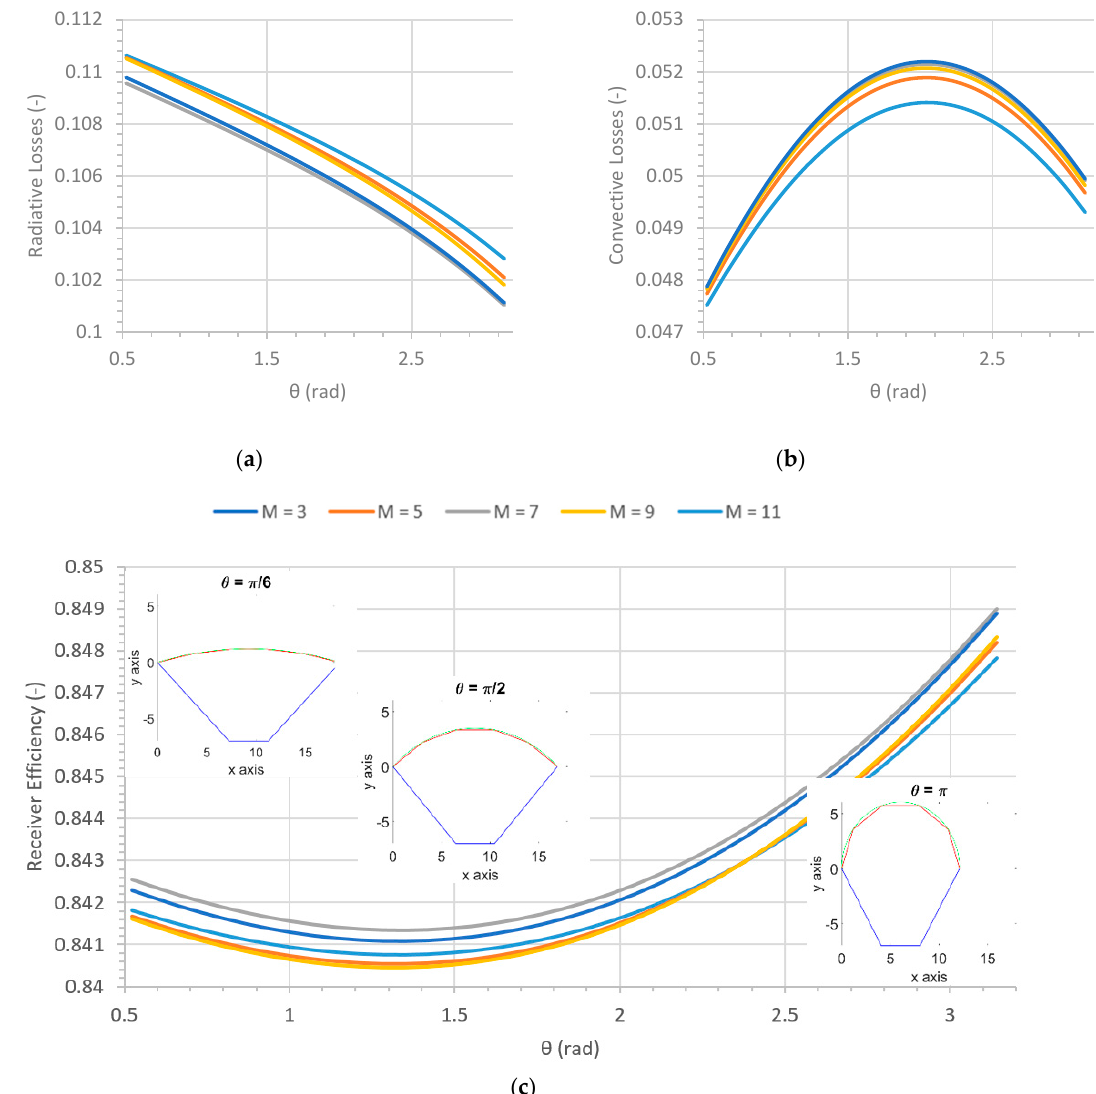
Figure 5. Influence of the absorber geometry (i.e., of the arc) on the radiative ( a ) and convective losses ( b ), both normalized by the receiver power, and on the receiver efficiency ( c ), for the following parameters: d ape = 7 m, L ape = 4 m, H ape = 5 m and α = 0.